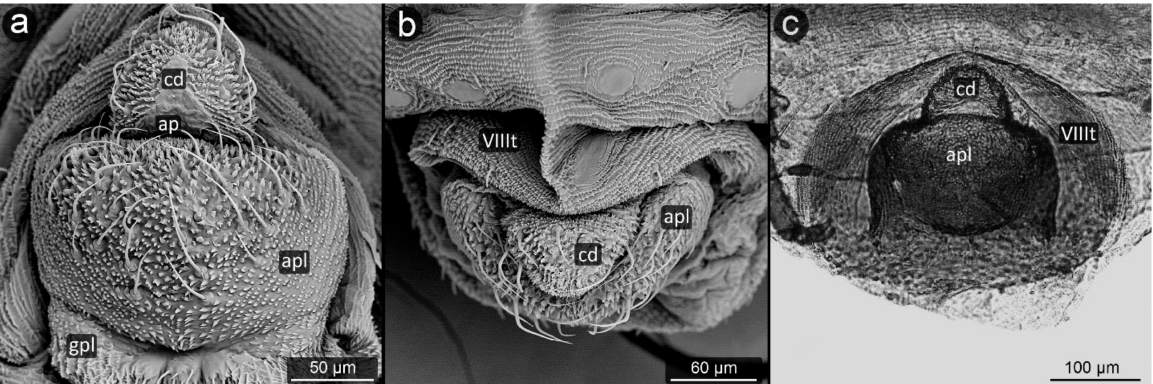
Figure 14. Perianal structure of Anuraphis catonii ; ( a )—rear view (SEM), ( b )—dorsal view (SEM), ( c )— rear view in light microscopy. Abdominal tergite VIII: with a spinal tubercles in its dorsal part; several short, blunt setae at the distal